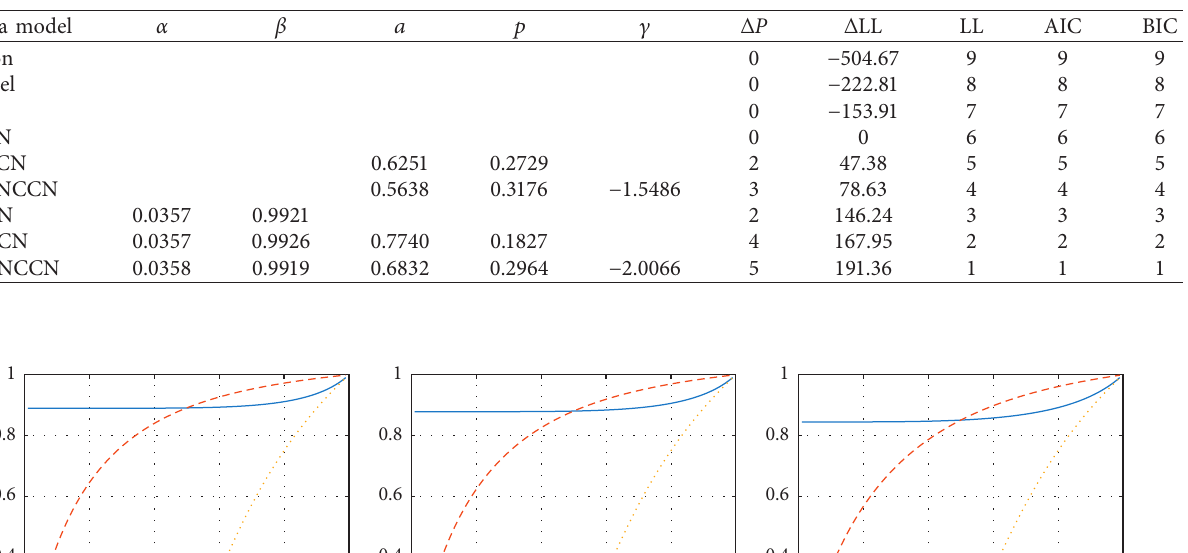
Table 9: Fitting results of bivariate copula models